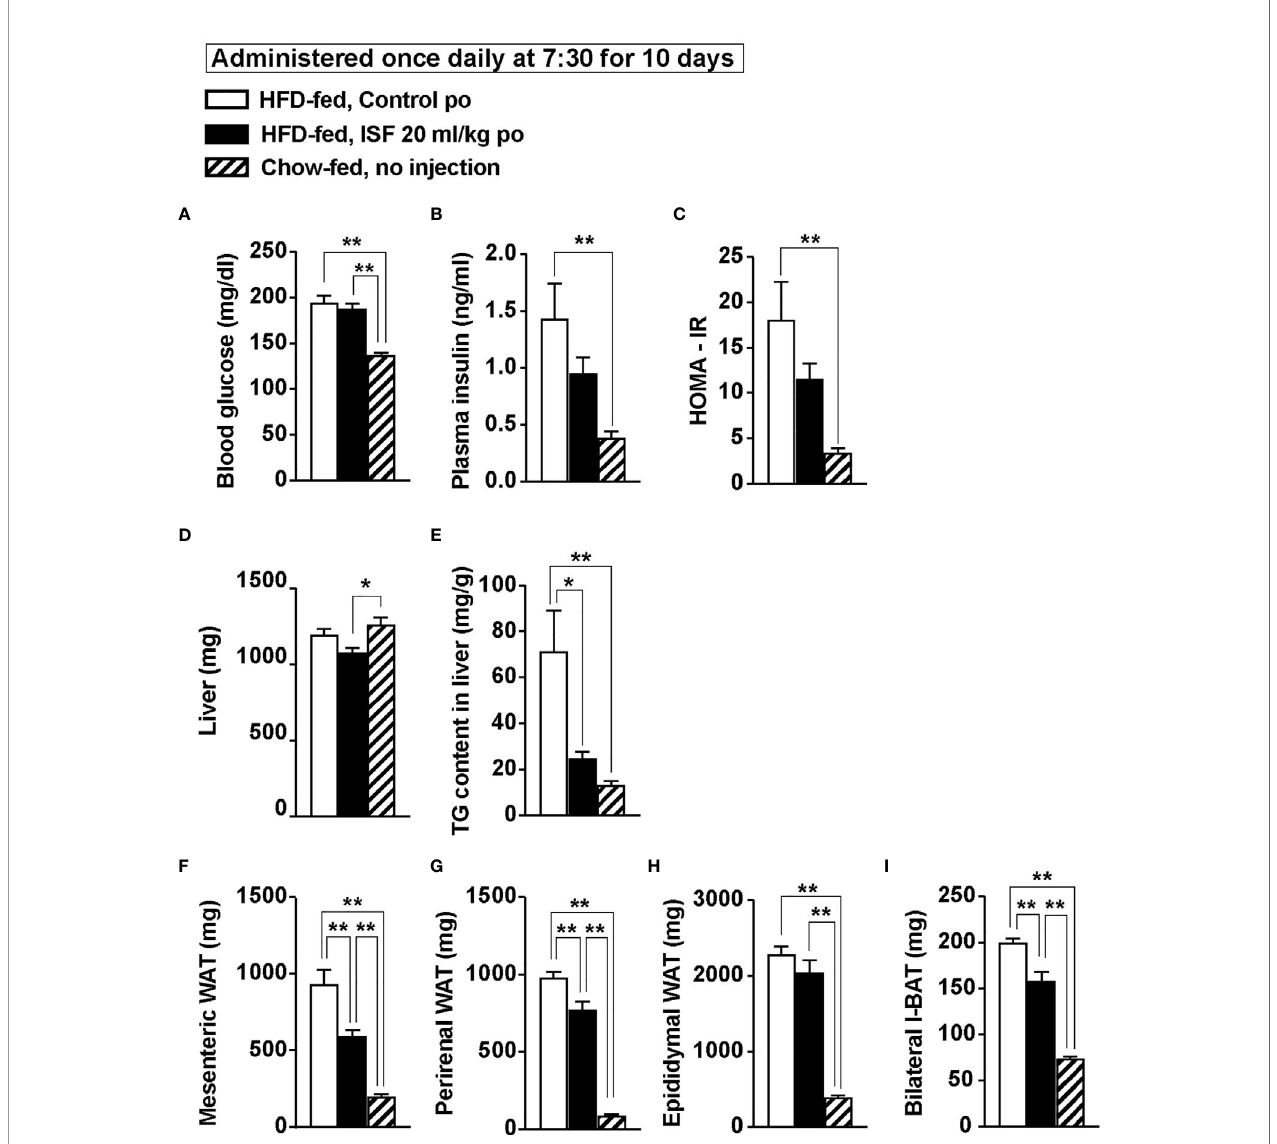
FIGURE 7 | Subchronic po administration of 20 ml/kg ISF at LP onset reduced hepatic triacylglycerol (TG) content and ameliorates visceral obesity on Day 11 in HFD-fed obese mice. (A – C) Subchronic administration of ISF (20 ml/kg/day) did not change fasting glucose (A) , but tended to attenuate hyperinsulinemia (B) and insulin resistance (C) in DIO mice on Day 11. (D – I) Subchronic ISF treatment did not affect liver weight (D) , but markedly reduced hepatic TG content (E) and weight of visceral white adipose tissues (WAT) including mesenteric, perirenal and epididymal WAT (F – H) on Day 11. ISF also reduced bilateral interscapular brown adipose tissues (I-BAT, I ). n = 5. * p < 0.05 and ** p < 0.01 by one-way ANOVA followed by Tukey ’ s test (A – I)